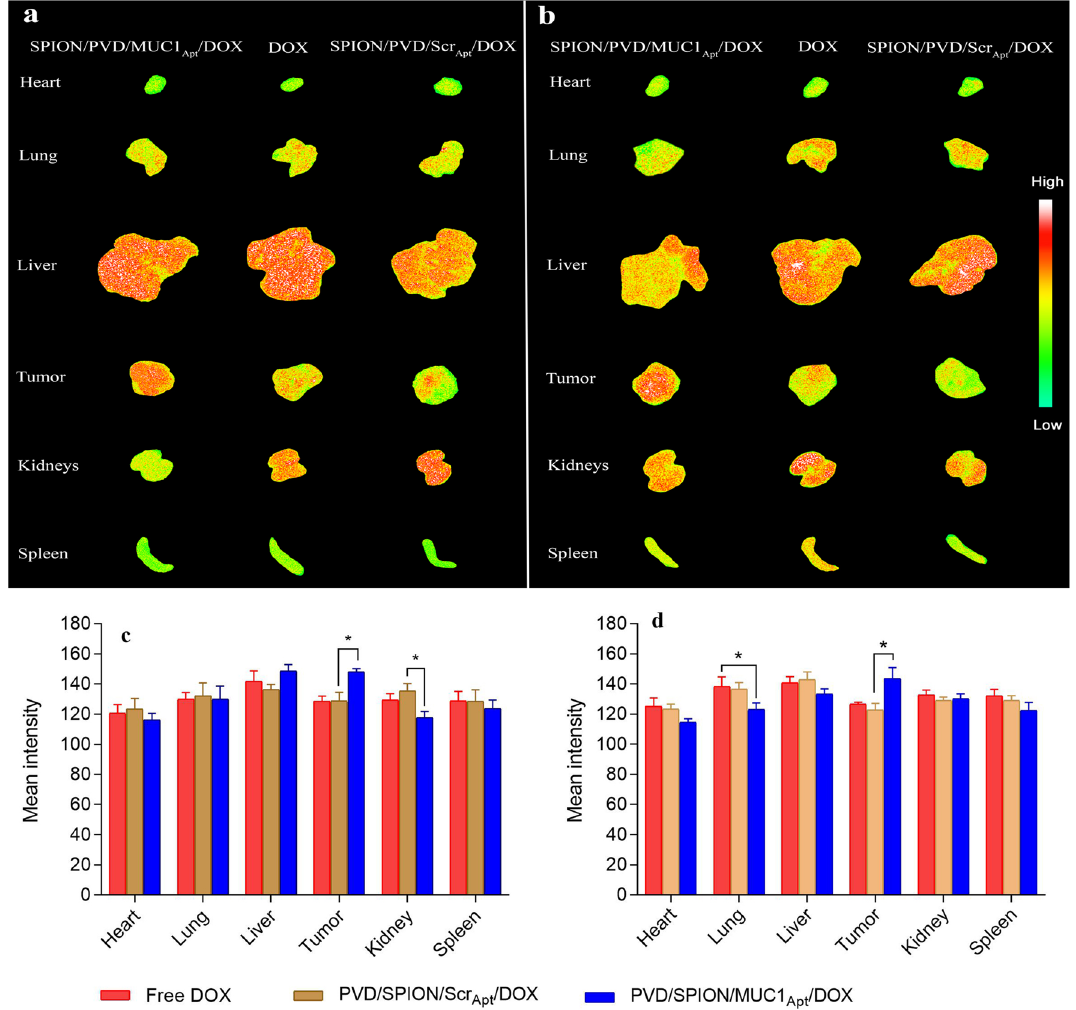
Figure 7. The ex vivo fluorescence images and ROI analysis of tumor and major organs (liver, spleen, kidneys, heart, and lungs) of C26 tumor-bearing BALB/c, ( a , c ) 6 h and ( b , d ) 24 h post-injection of SPION/PVD/ MUC1 Apt /DOX, SPION/PVD/Scr Apt /DOX and free DOX (with equivalent DOX concentration: 0.2 mg/kg). Statistical analysis of parts c and d was performed using GraphPad Prism Version 8.0 (https:// www. graph pad.